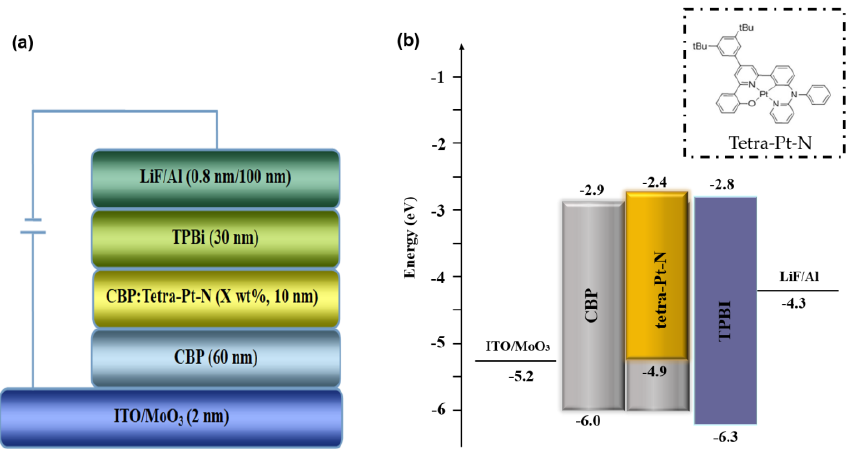
Figure 1. The structure ( a ) and energy level diagrams ( b ) of the devices A-D. The inset shows the molecular structure of Tetra-Pt-N. molecular structure of